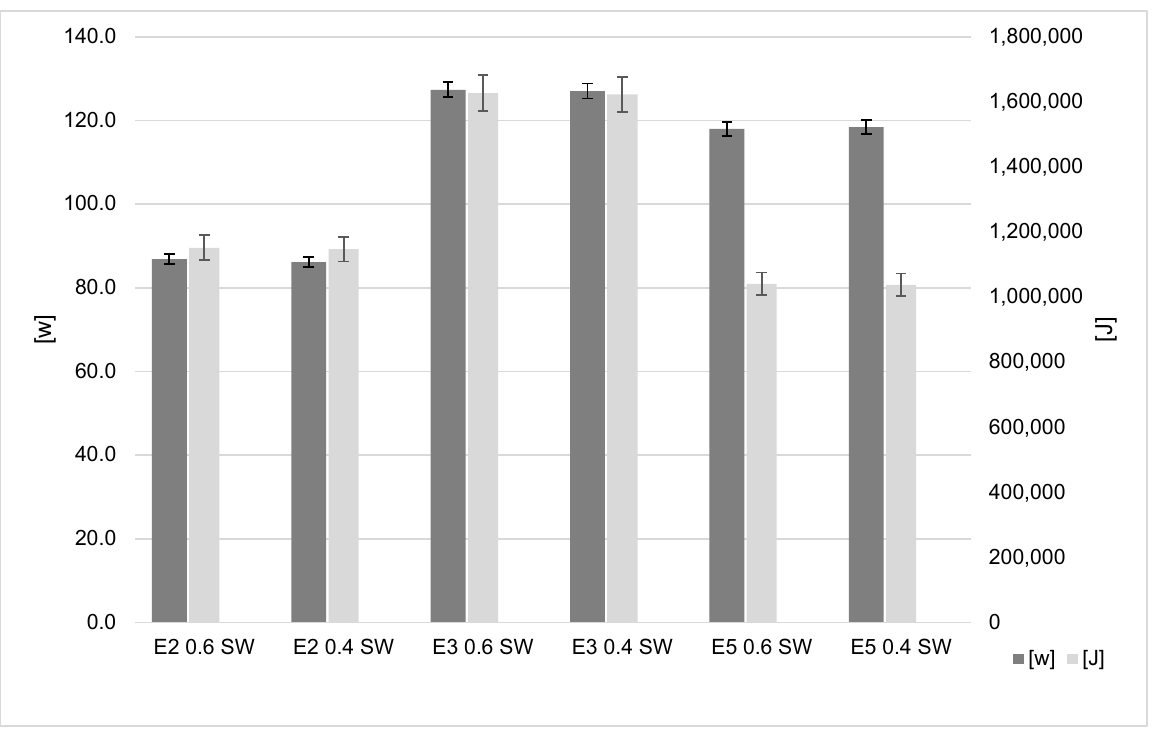
Figure 7. Support line width influence on energy results.